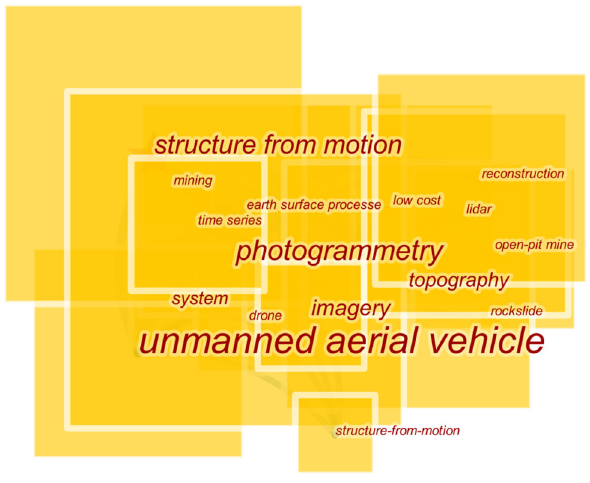
Fig. 2 Keywords from the published papers based on CiteSpace. The size of squares and words reflects the frequency of words used. The larger size show the higher frequency